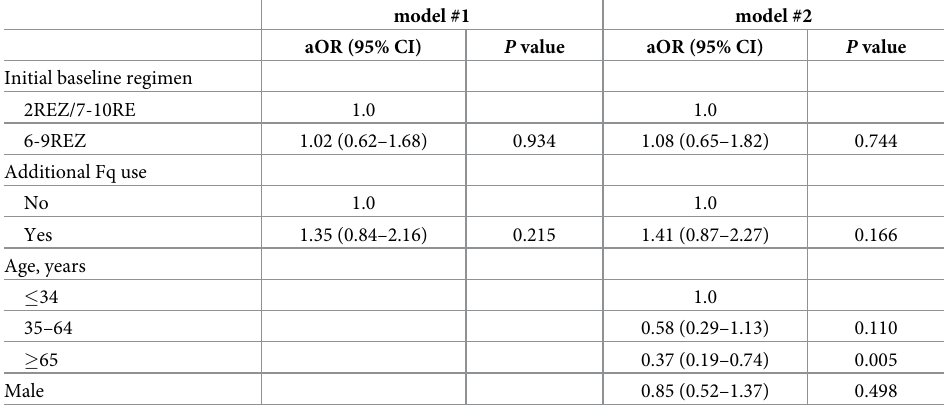
Table 4. Multivariable logistic regression assessing factors associated with positive treatment outcomes.